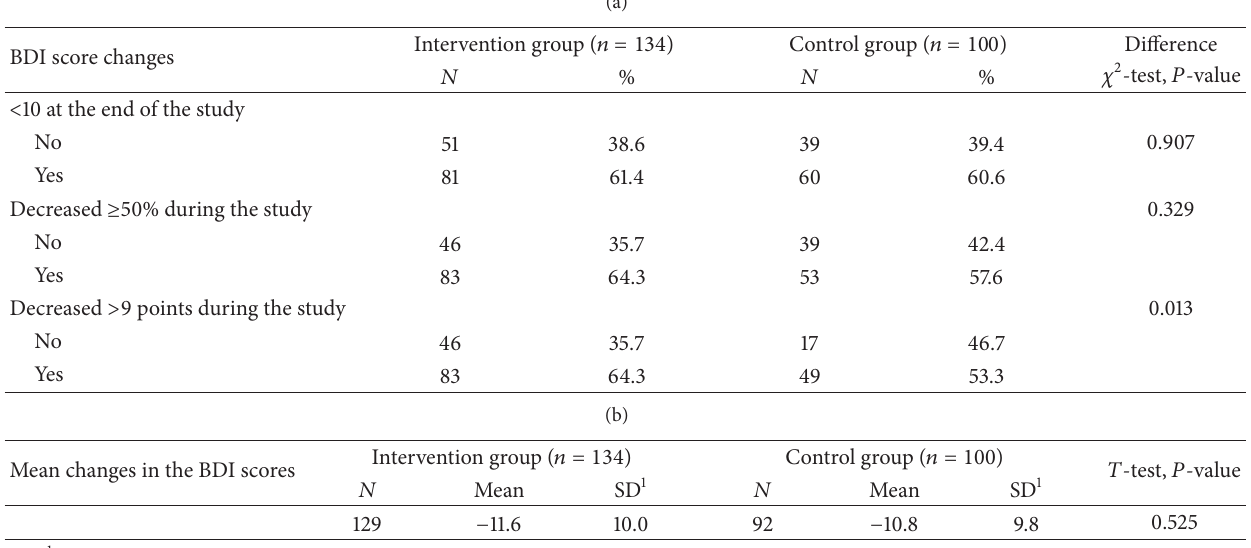
Table 3: The Beck Depression Inventory (BDI) scores and changes in BDI scores during the follow up period, measured in four different ways in the intervention and control groups.